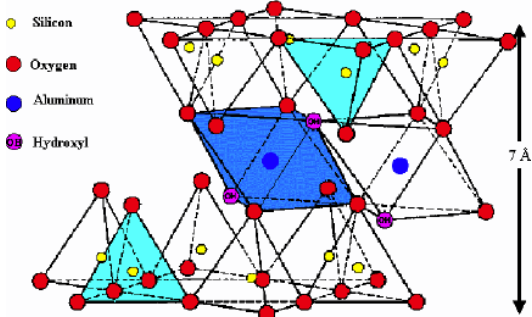
Figure 1. Cristallographic structure of Maghnite (Basic repeating unit is [Si